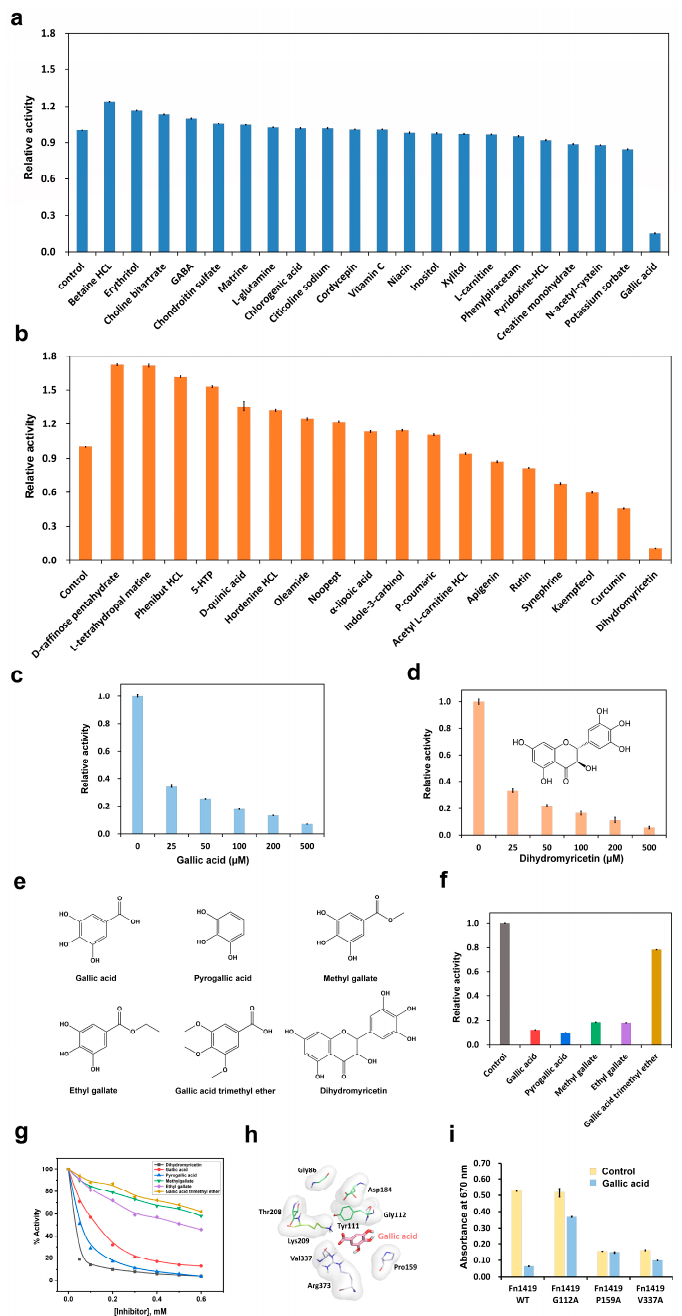
Figure 4. Screening for natural inhibitors of Fn1419. Inhibitor screening of ( a ) 21 hydrophilic compounds and ( b ) 18 hydrophobic compounds to Fn1419 in vitro. The error bars represent standard deviation of three replicates. Titration of ( c ) gallic acid and ( d ) dihydromyricetin to Fn1419. The error bars represent the standard deviation of three replicates. ( e ) Chemical structures of gallic acid, pyrogallic acid, methyl gallate, ethyl gallate, gallic acid trimethyl ether, and dihydromyricetin. ( f ) Fn1419 inhibition study with pyrogallic acid, methyl gallate, ethyl gallate, and gallic acid trimethyl ether. The error bars represent standard deviation of three replicates. ( g ) IC 50 values of Fn1419 for dihydromyricetin, gallic acid, pyrogallic acid, methyl gallate, ethyl gallate, and gallic acid trimethyl ether. ( h ) Docking of gallic acid to Fn1419. Gallic acid or PLP-binding residue are indicated by gray and green sticks, respectively. ( i ) Measurement of Fn1419 activity with Fn1419 mutants (G112A, P159A, and V337A) predicted the gallic acid binding. The error bars represent standard deviation of three